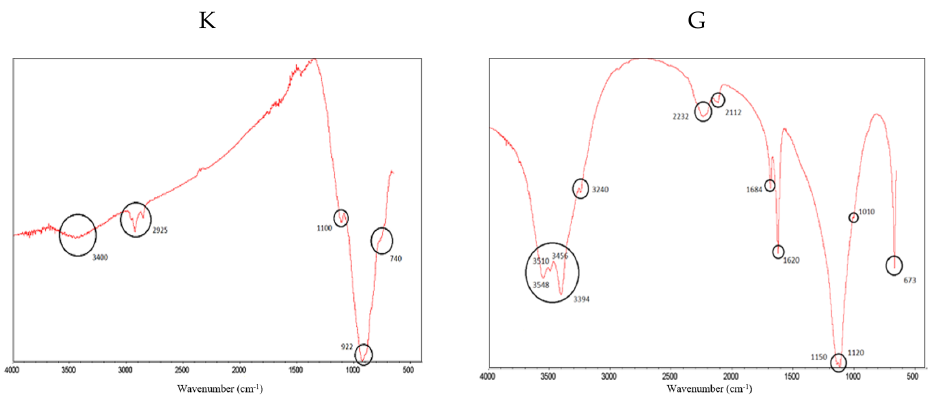
Figure 3. FTIR spectra for clinker (K) ( left ) and gypsum (G) ( right ). The most representative peaks have been highlighted.